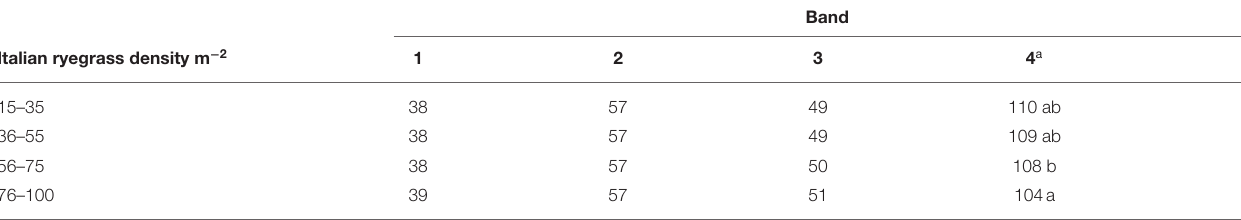
TABLE 6 | Spectral reflectance of Italian ryegrass grown in different densities (plants m − 2 ) across imagery dates and